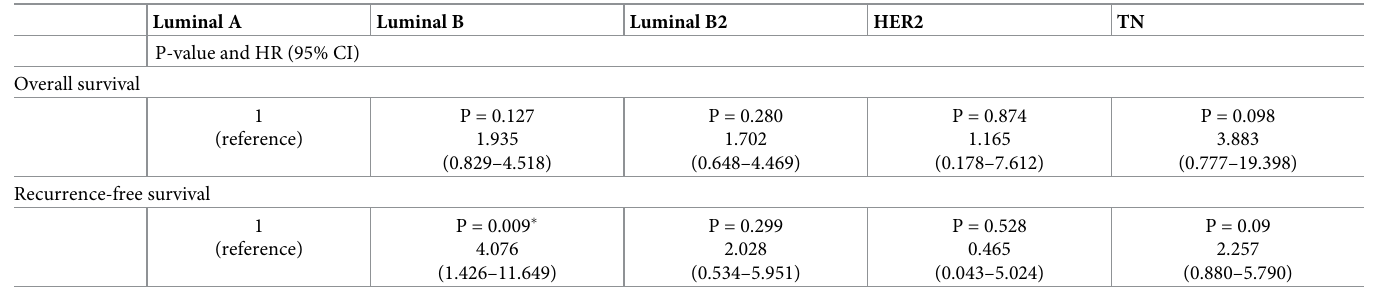
Table 2. Multivariate analysis of overall and recurrence-free survival according to breast cancer subtype.